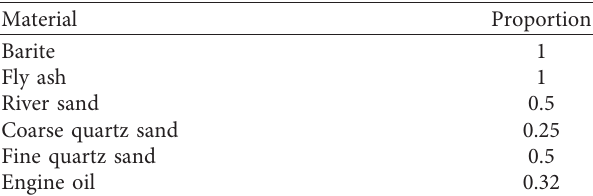
Figure 5: Direct shear test. (a) Direct shear apparatus; (b) failure surface of the direct shear test. Table 3: Model of surrounding rock with similar material mix